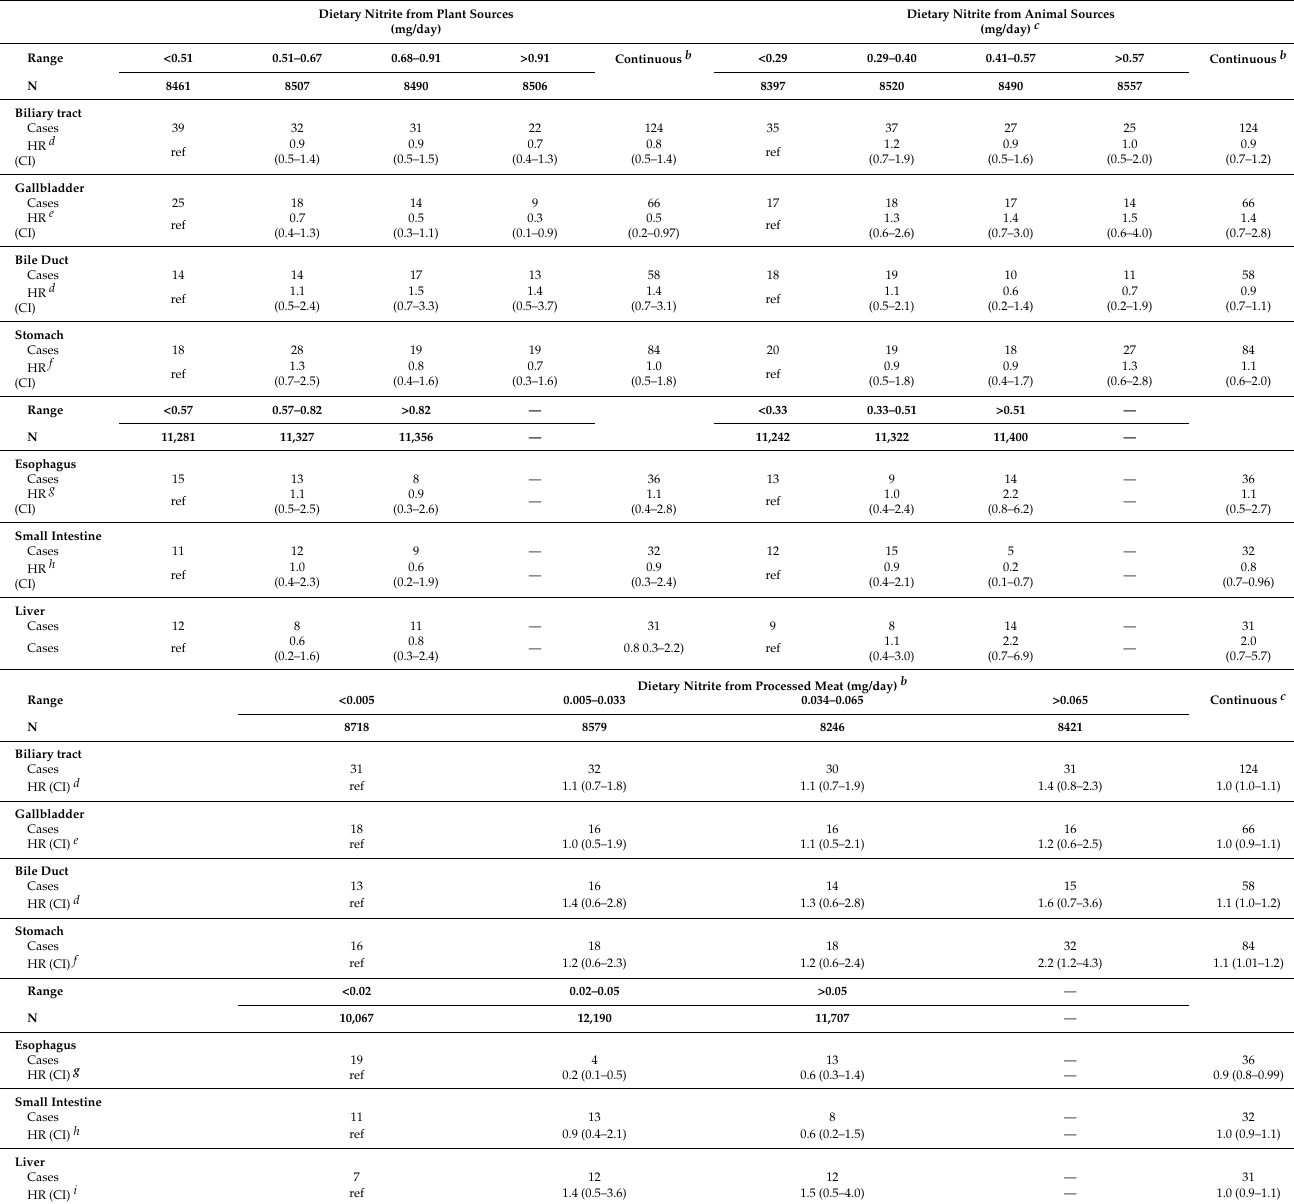
DietaryNitritefromAnimalSources (mg/day) c